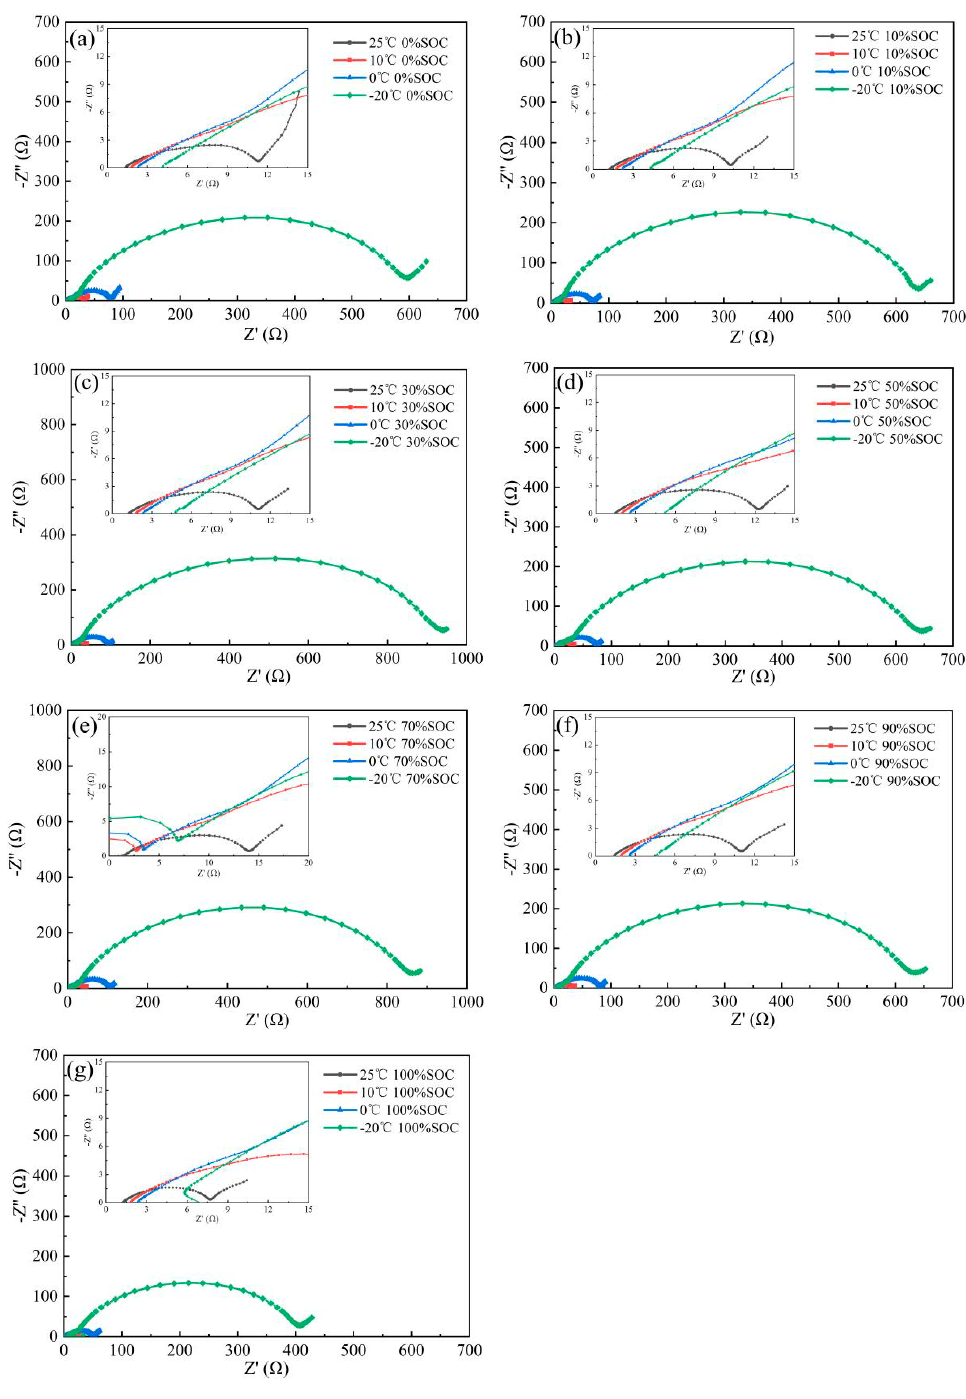
Figure 6. EIS spectrum of the graphite ( a ) 0% SOC; ( b )10% SOC; ( c ) 30% SOC; ( d ) 50% SOC; ( e ) 70% SOC; ( f ) 90% SOC; ( g ) 100% SOC.